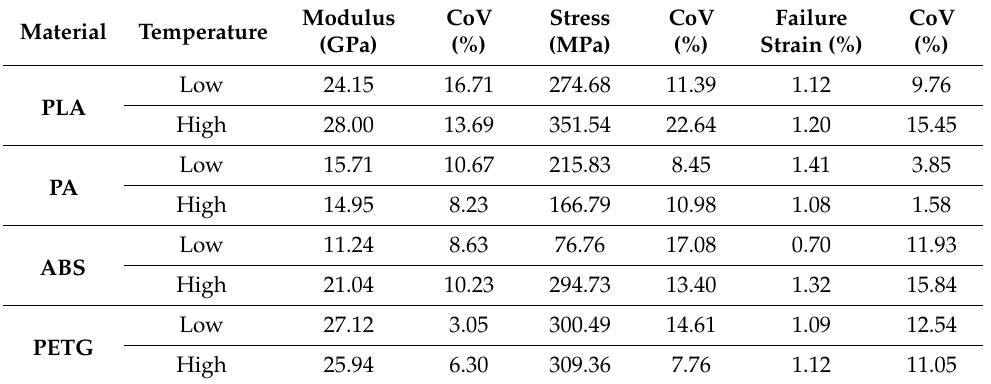
Table 5. Tensile test results of showing modulus, stress and strain at break and coefficient of variance (CoV).